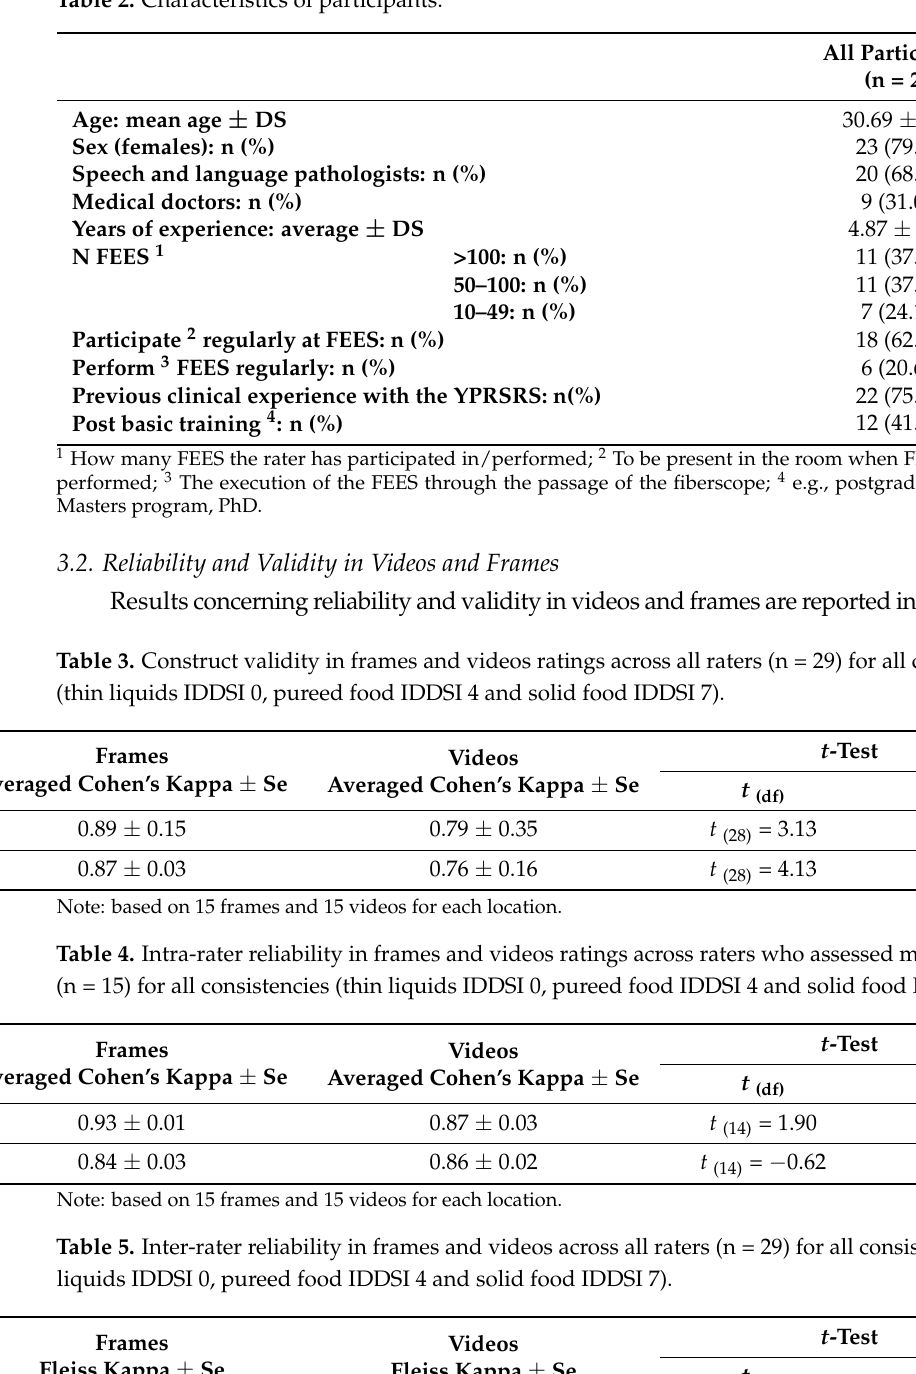
Table 2. Characteristics of participants.